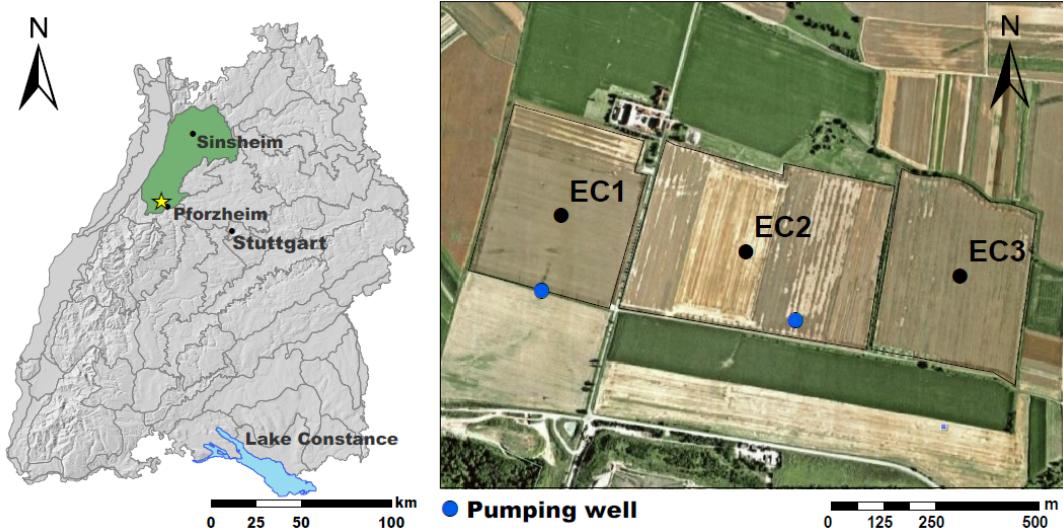
Figure 1. The study region “Kraichgau” (green) on the map of the federal state Baden-Württemberg. Location of the central study site is indicated by a yellow star. The right panel shows a close-up of the central study site. That site consists of three fields (EC1-3). An eddy covariance station (black full point) is installed in the center of each